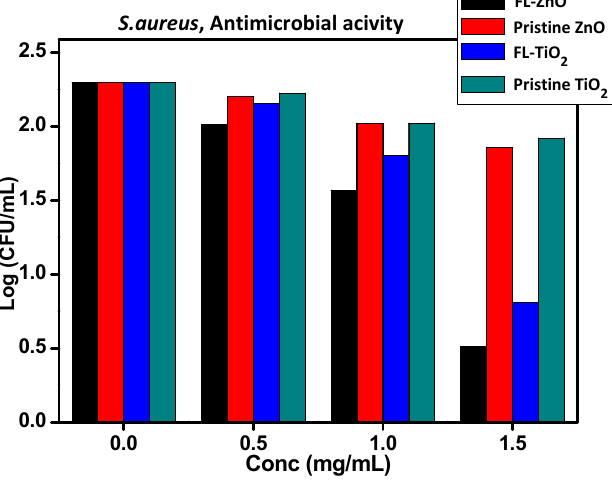
Figure 8. Antimicrobial activity of E. coli against pristine ZnO (48%), FL–ZnO (5.2%), pristine TiO 2 (52%) and FL–TiO 2 (6%).